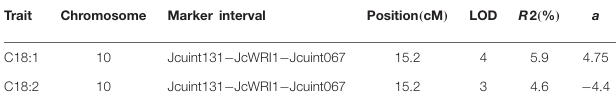
TABLE 2 | Composite interval mapping for JcWRI1 . Trait